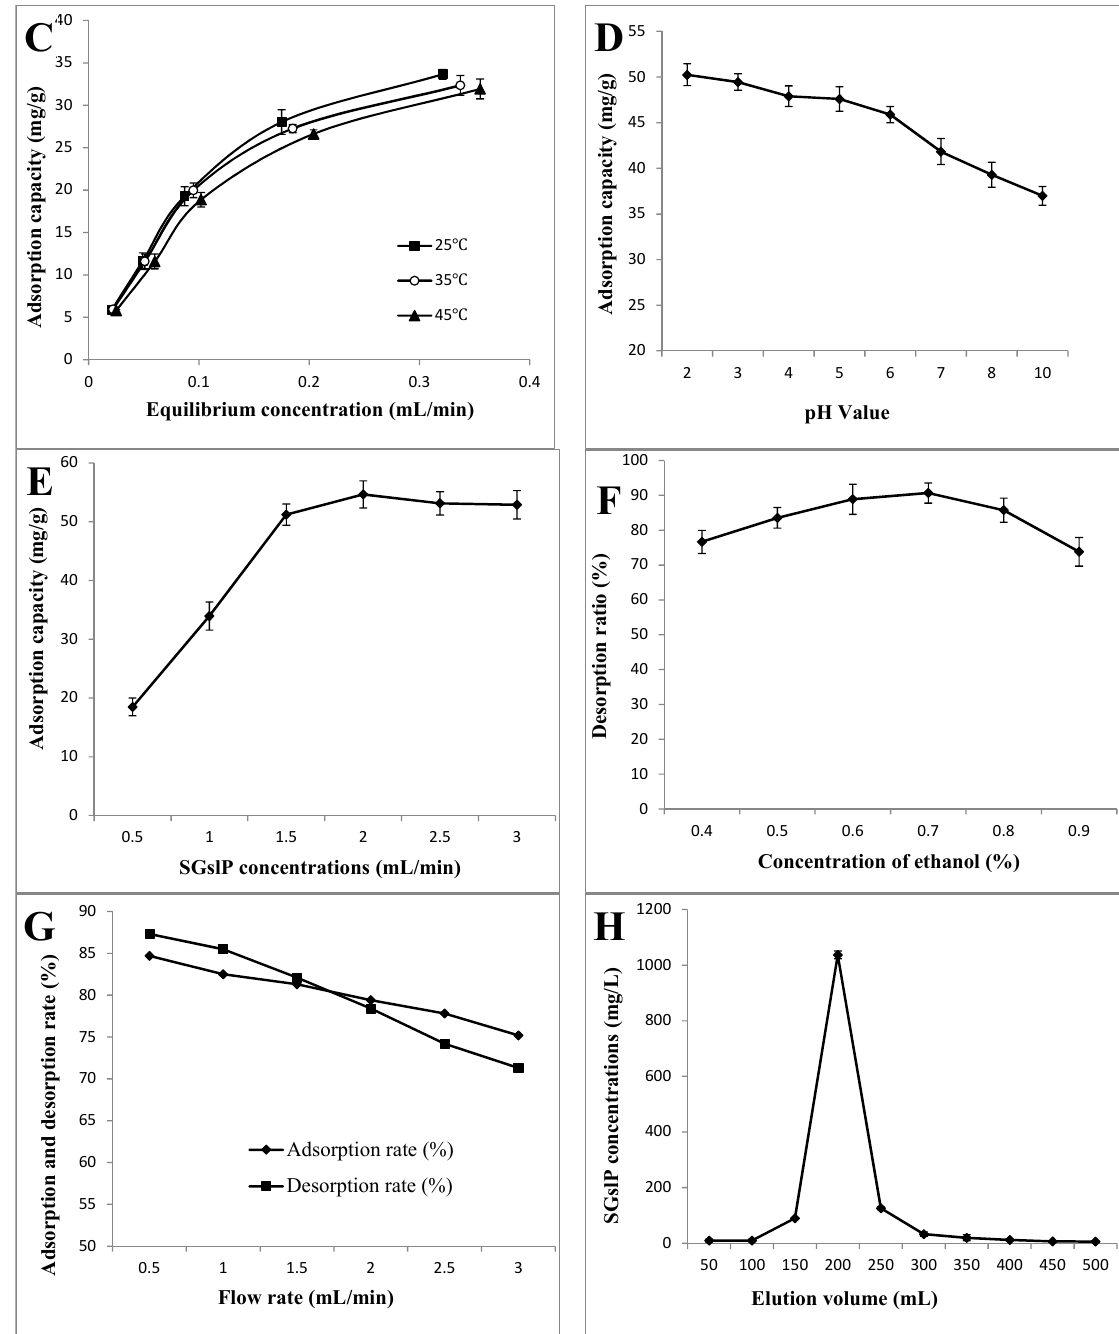
Figure 1. Adsorption and desorption properties of the X-5 resin: ( A ) static adsorption curve; ( B ) static desorption curve; ( C ) adsorption isotherms; ( D ) effect of pH value on the adsorption capacity; ( E ) effect of the concentration of SGslP on the static adsorption; ( F ) effect of the ethanol concentration on the desorption ratio; ( G ) effect of the flow rate on the adsorption capacity/desorption ratio n; and ( H ) dynamic desorption curve of the Sphallerocarpus gracilis stems and leaves polyphenols (SGslP).